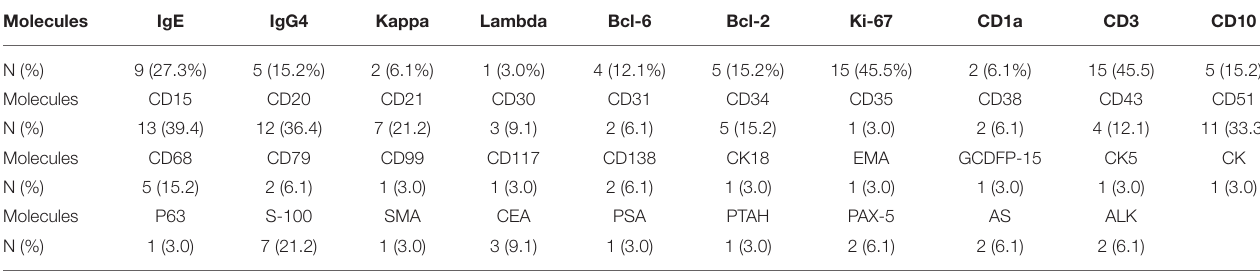
TABLE 2 | Positive rate of immunohistochemical molecules in Kimura